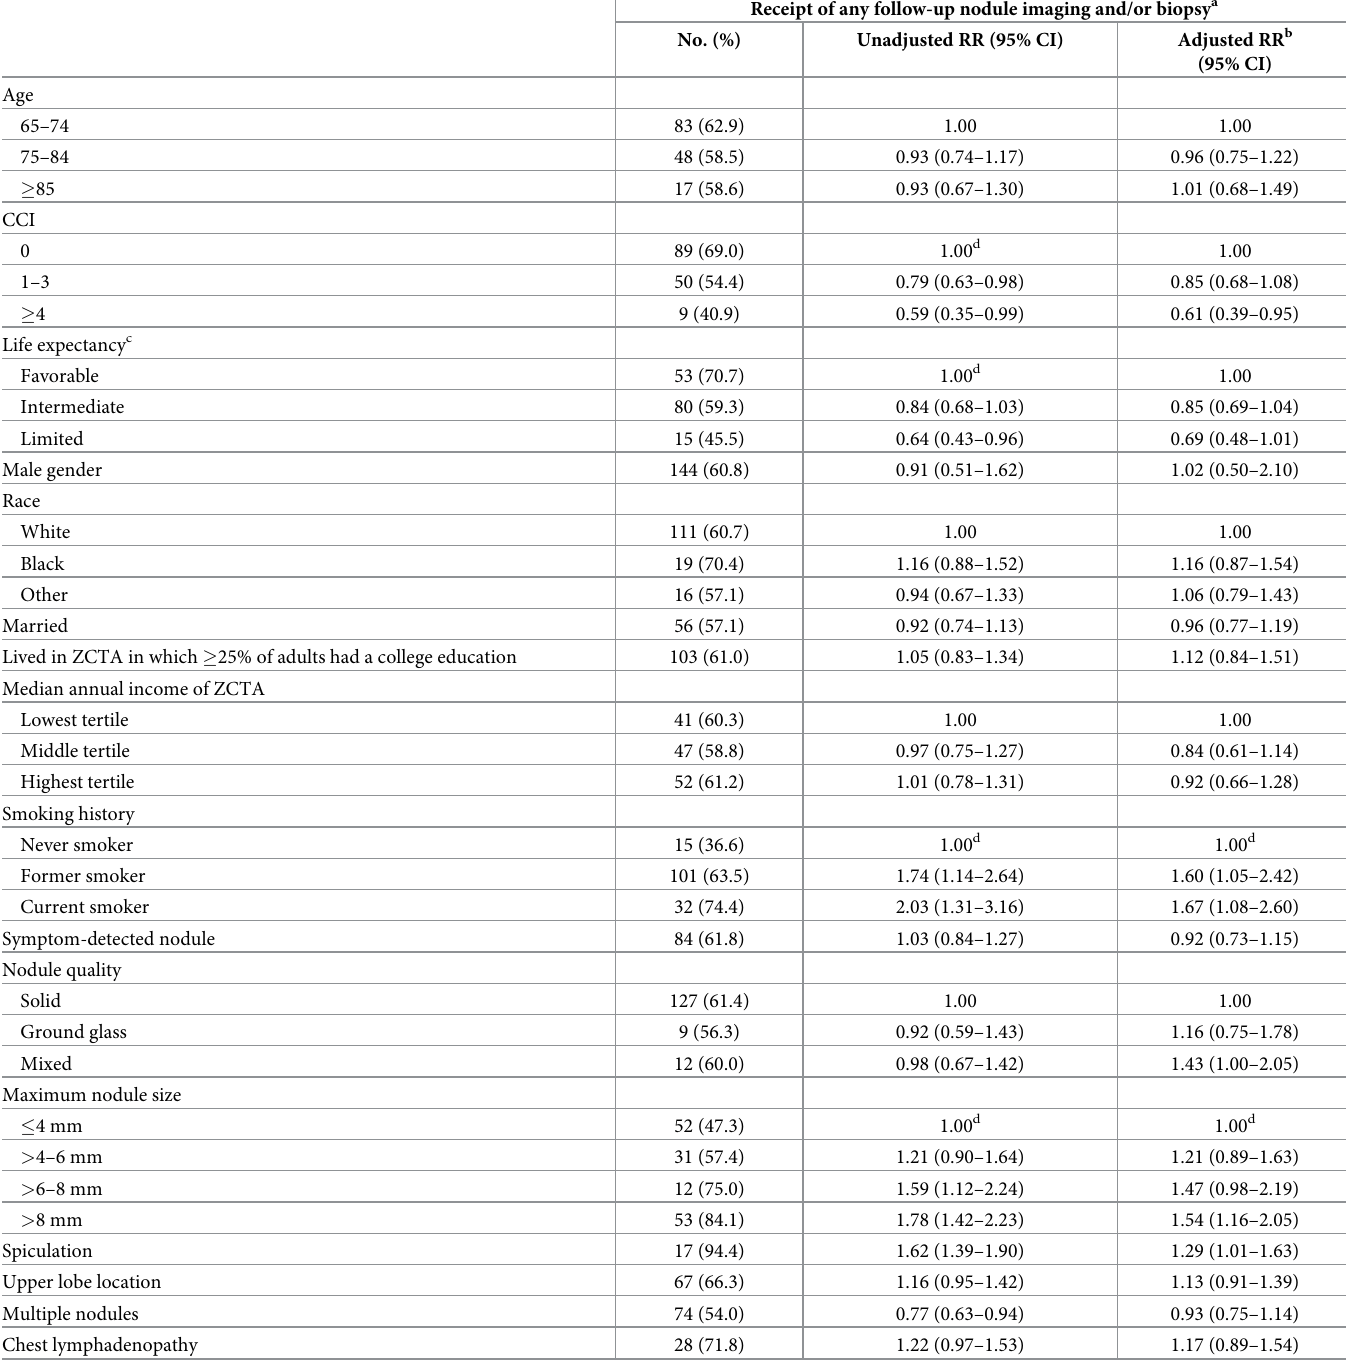
Table 2. Patient and baseline nodule characteristics associated with receipt of any nodule imaging and/or biopsy during four-year follow-up in veterans age (cid:21) 65 with newly diagnosed pulmonary nodule(s) in 2008–09 (n = 243). Receipt of any follow-up nodule imaging and/or biopsy